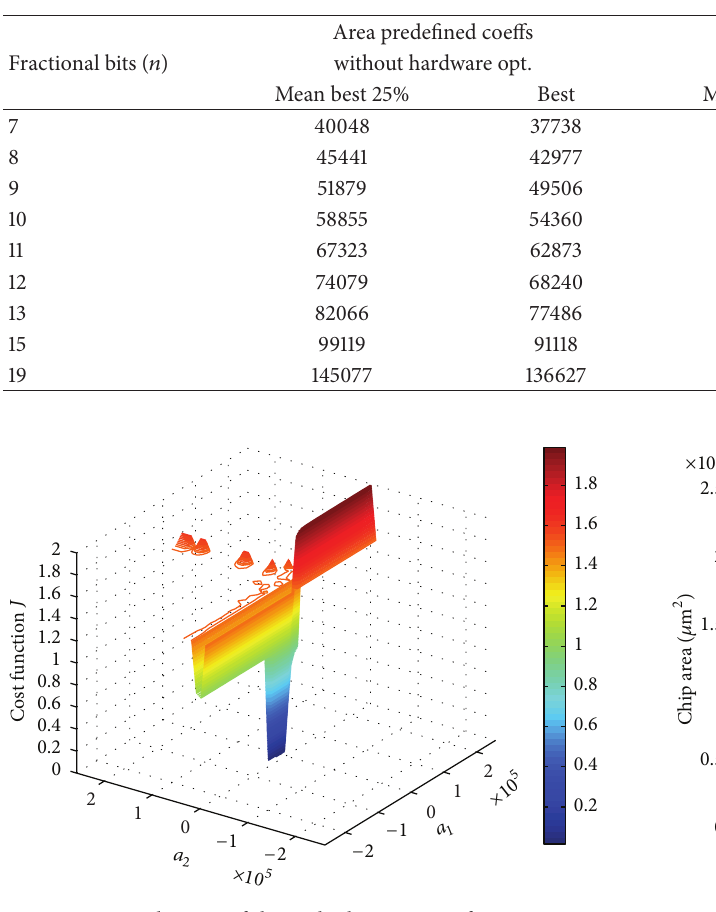
Figure 13: Visualisation of the multiobjective cost function 𝐽 over 𝑎 𝑎 1 and 2 .